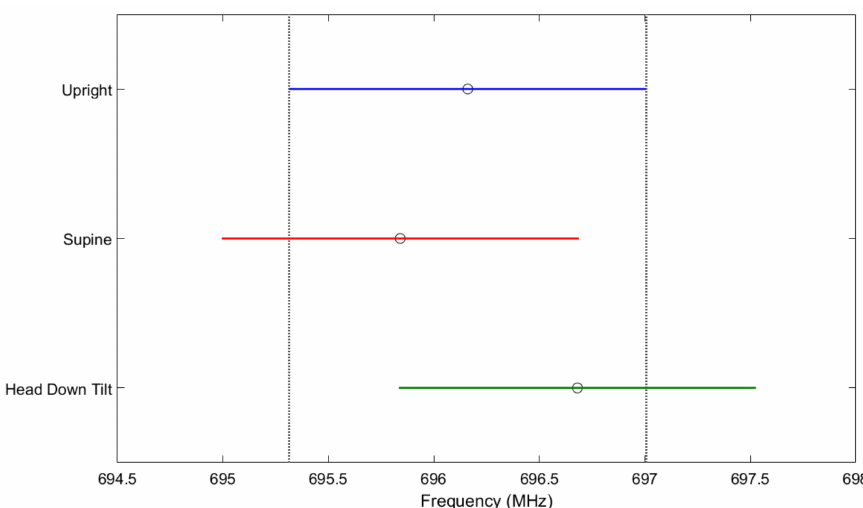
Figure 13. Repeatability test due to postural changes on a mannequin control. The sensor readings for the various positions had approximately a 2.5 MHz shift due to postural changes. When compared to the 45 MHz shift seen on a human due to bio-fluid shift, the shift due to postural changes were considered negligible. The blue line represents the variation of resonant frequency for the upright position, the red line represents the variation in supine, and the green line represents the variation during head down